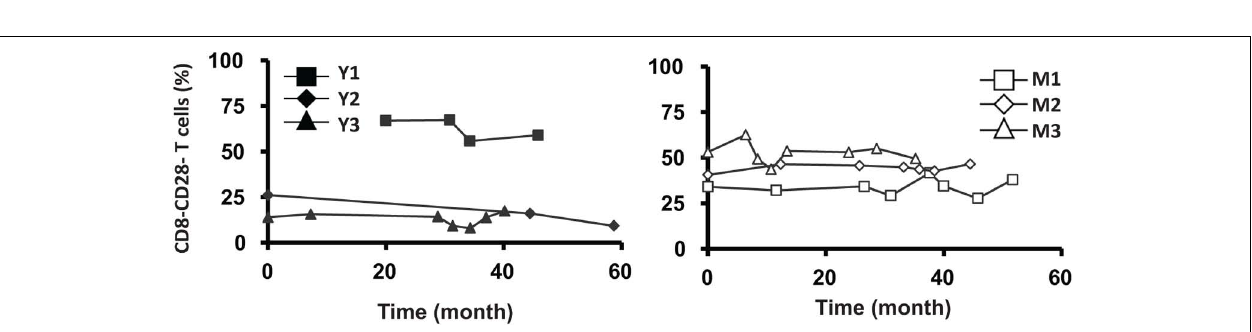
FIGUREA3 | CD8 + CD28 − T cells of six frequent leukapheresis donors throughout 3–5 years. PBMC were isolated and stained with CD8 and CD28.The percents of CD8 + CD28 − in total CD8T cells are presented.